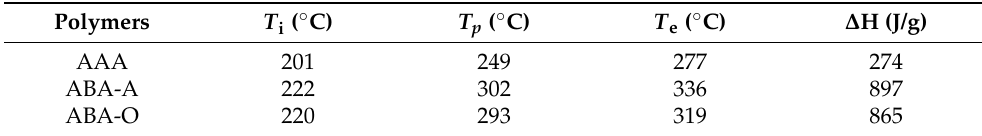
Figure 6. DSC curves of three polymers at a heating rate of 10 ◦ C/min. Table 4. The DSC analysis results of three